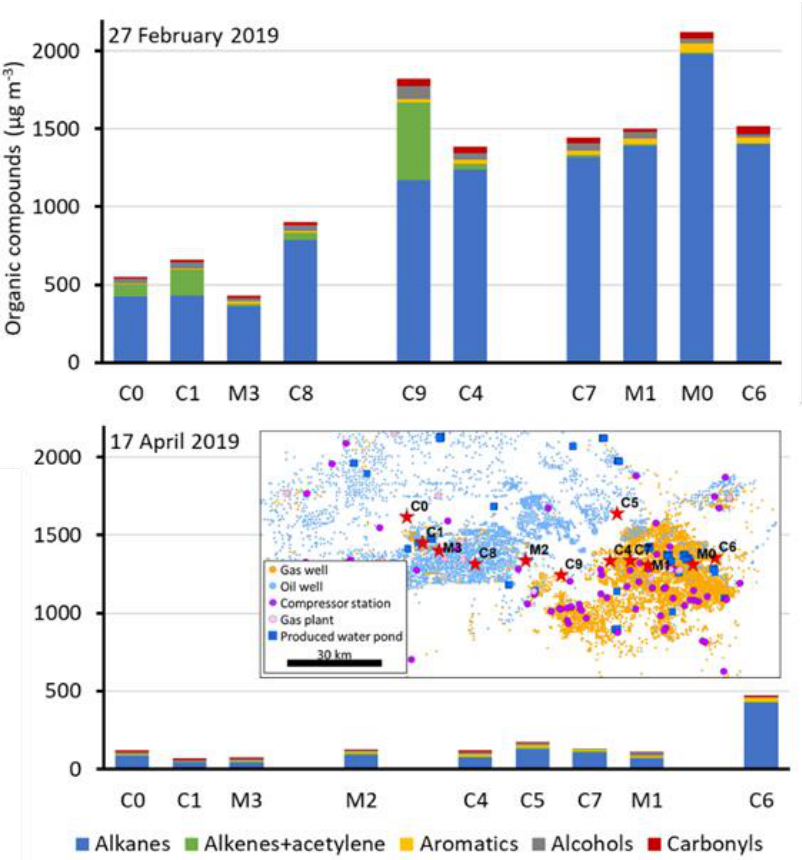
Figure 3. Organic compound concentrations at all measurement stations on 27 February 2019 during a wintertime temperature inversion episode ( top panel ) and on 17 April 2019 when snow had melted and no inversion existed ( bottom panel ). Blank spaces exist because some samples failed to collect at some stations. The inset map shows the locations of the monitoring stations as red stars.